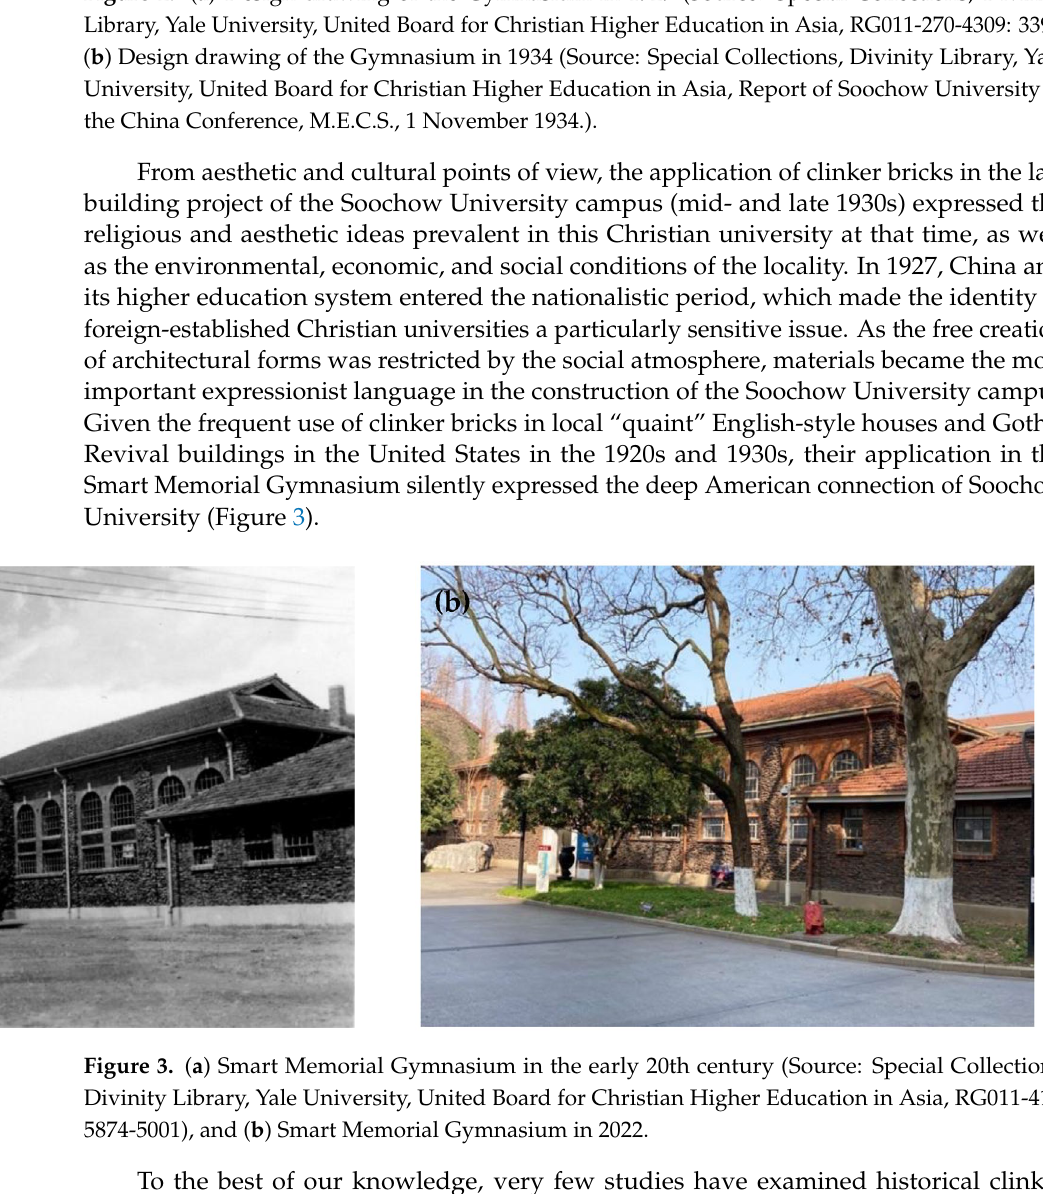
Figure 2. ( a ) Design drawing of the Gymnasium in 1929 (Source: Special Collections, Divinity Li-